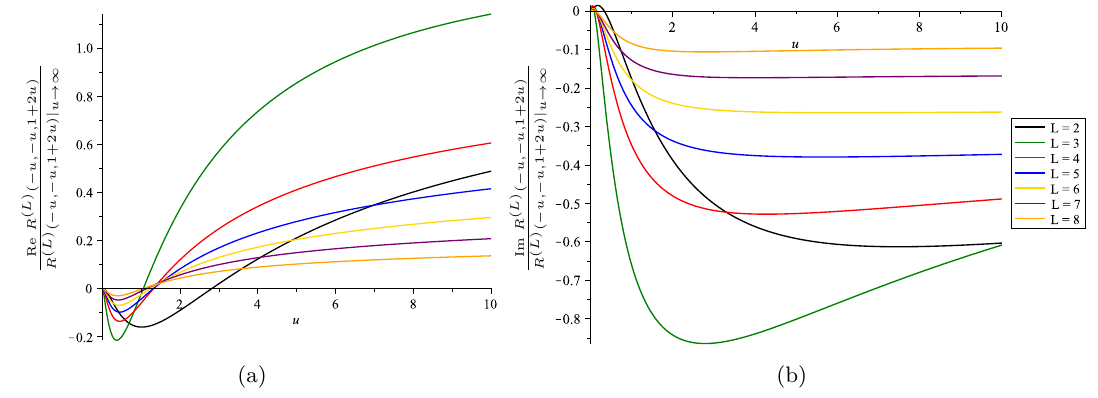
Figure 6. The real (a) and imaginary (b) parts of the remainder function R ( L ) on the u = v line in region IIIa. We have normalized these functions by their value at u → ∞ , which is